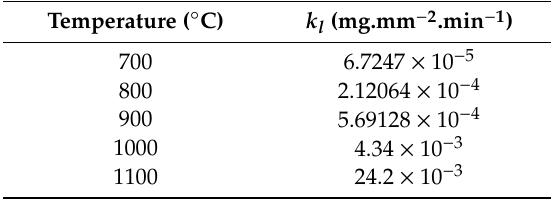
Table 6. The calculated oxidation weight gain line rate constant of Fe–1Cr–0.2Si steel obtained at different temperatures.